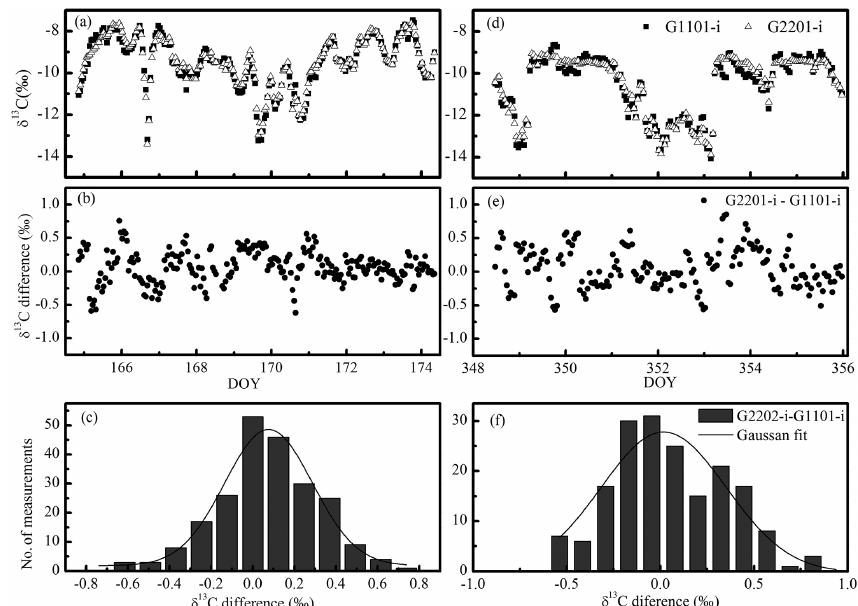
Figure 6. Time variations of (a) and (d) hourly atmospheric δ 13 C, (b) and (e) difference between the Picarro G1101-i and G2201-i analyzers, and (c) and (f) histogram of the differences. The left panels (a, b, c) show time variations measured before G1101-i was upgraded (G1101- i-original) (DOY 164–174) and the right panels (d, e, f) show those measured after G1101-i was upgraded (G1101-i-upgraded) (DOY 348–356).